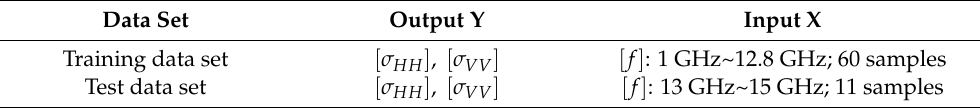
Table 4. Data set of the 3D sea surface backscattering coefficients varying with the frequency. Data Set